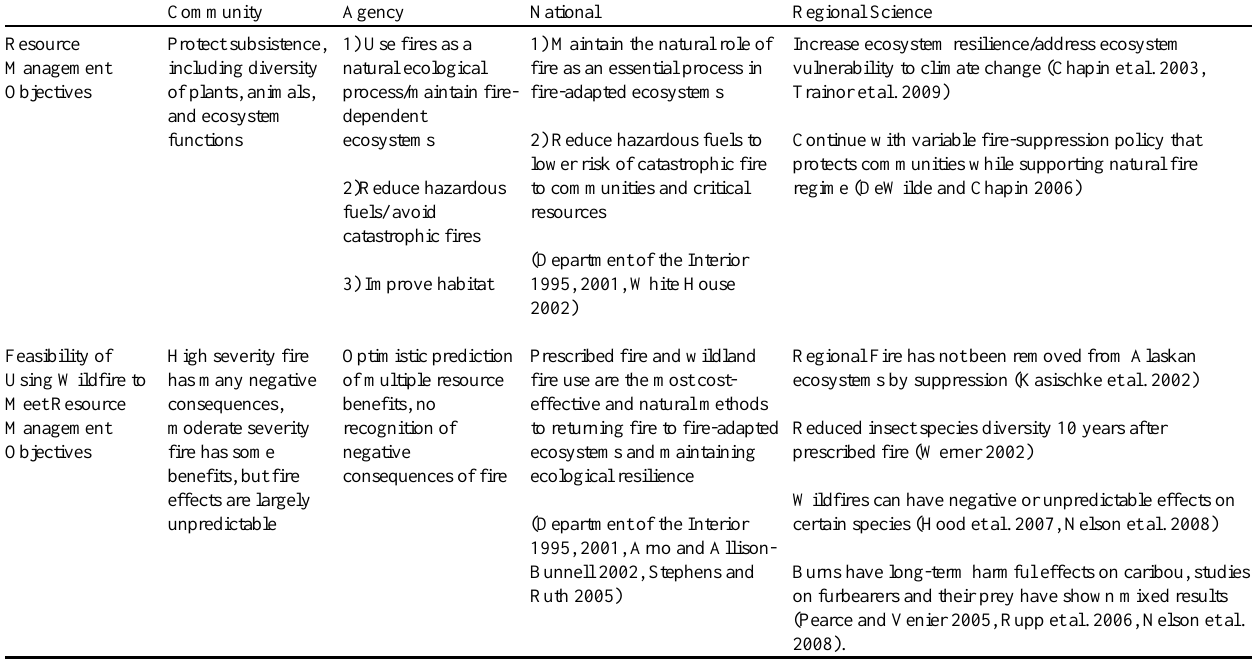
Table 4 . Feasibility of using fire to meet resource management